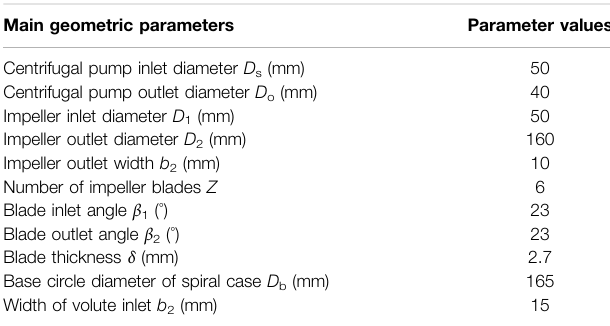
TABLE 1 | Main geometrical parameters of centrifugal pumps. Main geometric